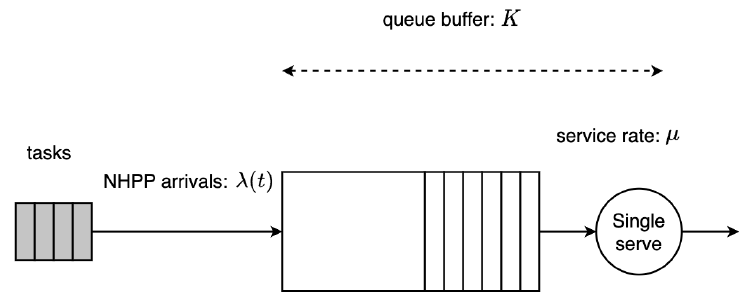
Figure 1. An M t / M /1/ K queueing